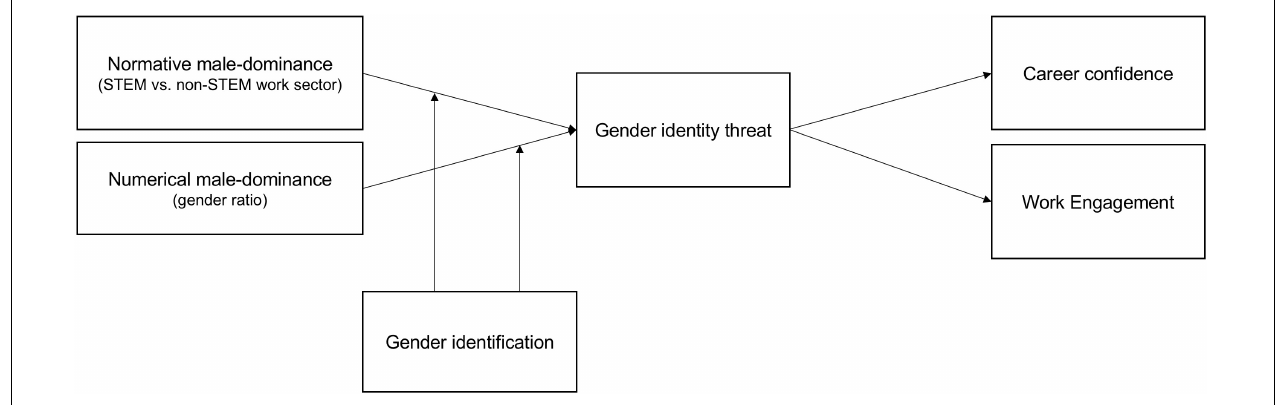
FIGURE 1 | Conceptual model with hypothesized